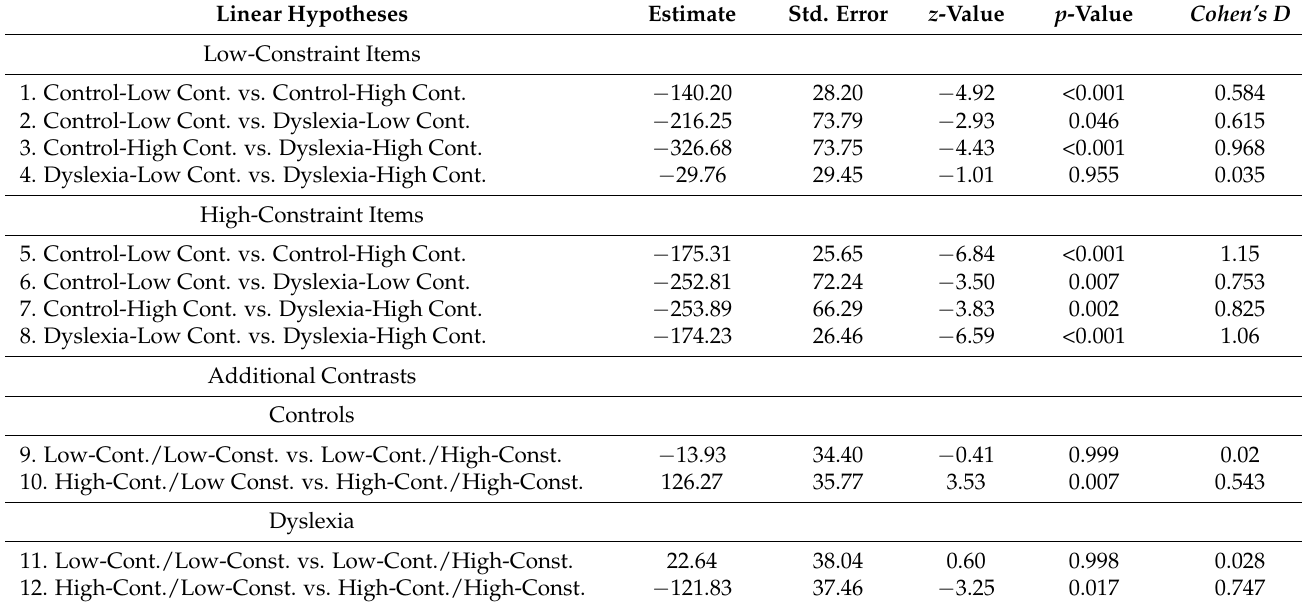
Table 4. Results of paired comparisons.